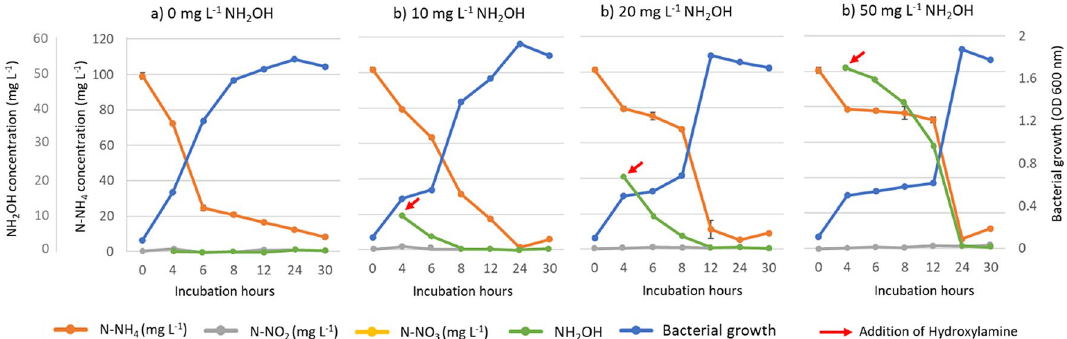
Figure 3. Dynamics of ammonium transformation with addition of hydroxylamine in different concentrations—strain Bzr02, ( a ) 0 mg L -1 or control, ( b ) 10 mg L −1 , ( c ) 20 mg L −1 and ( d ) 50 mg L −1 . Values represent the mean and the standard error (n =